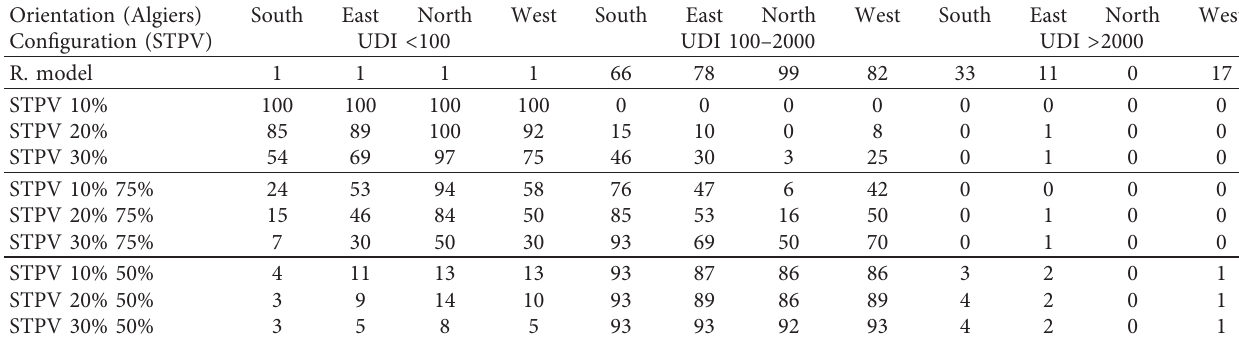
Table 16: UDI thresholds in cardinal orientations under CEI clear sky condition (Algiers